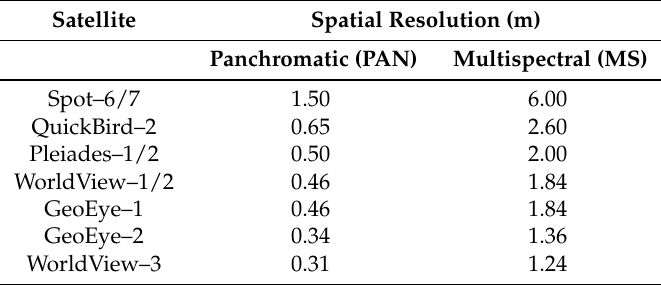
Table 1. Commercial optical satellites that offer images with high and very high spatial